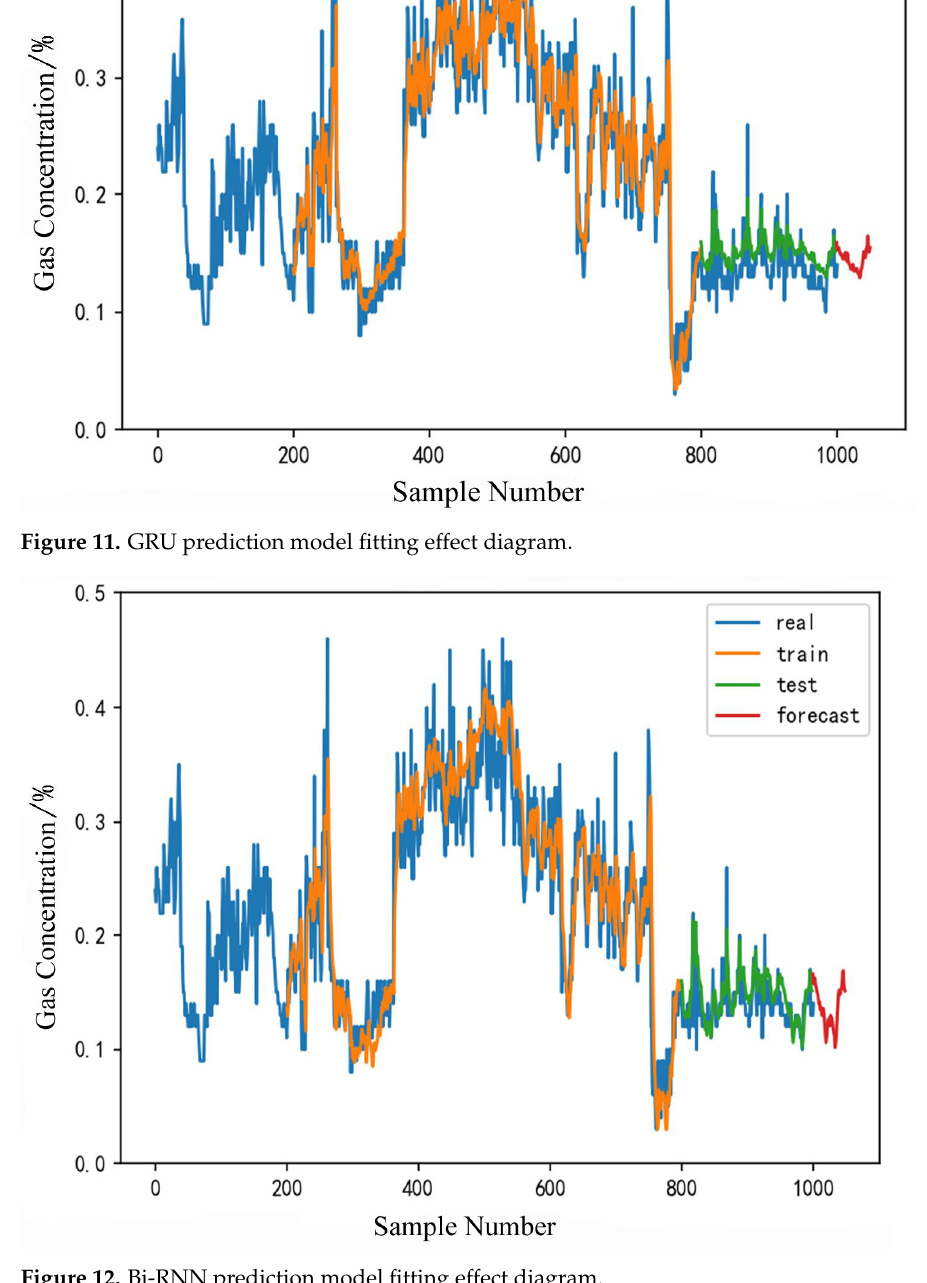
Figure 12. Bi-RNN prediction model fitting effect diagram.